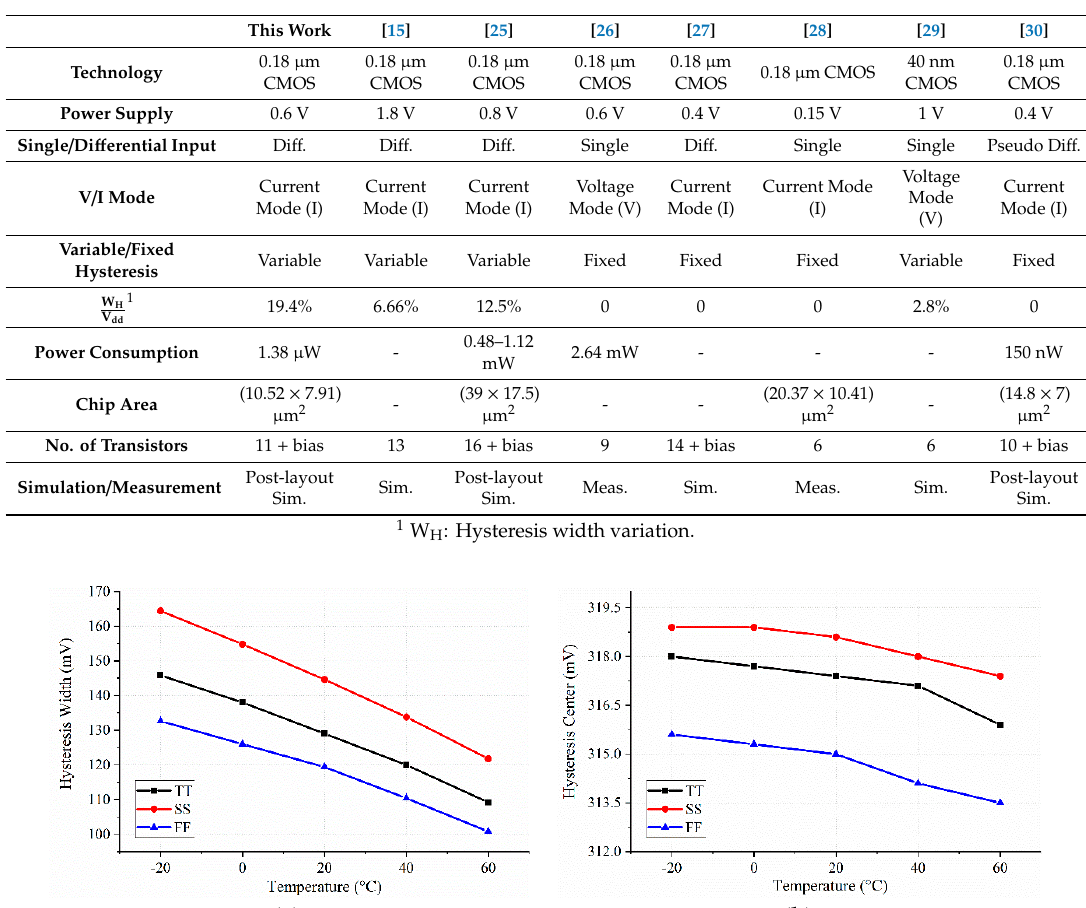
Table 2. Performance comparison of Schmitt triggers.